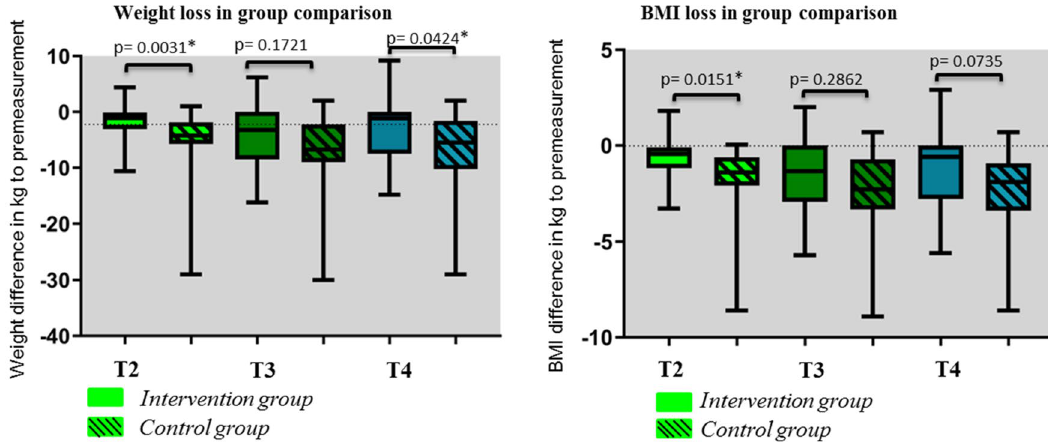
Figure 2. Weight and BMI loss in group comparison at measurement points T2 (before discharge), T3 (3 months after surgery and T4 (6 months after